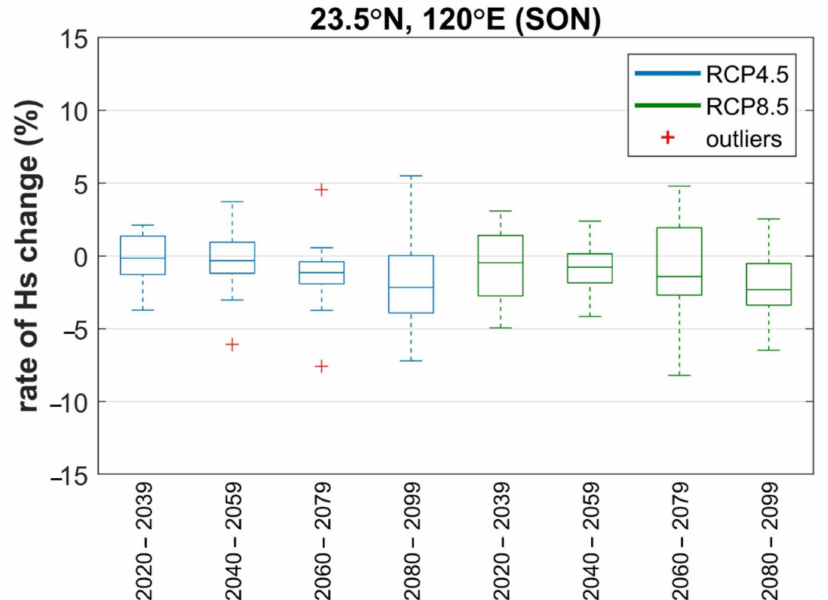
Figure 19. Box plot of rate of change in the seasonal mean of significant wave heights for each GCM, with respect to the reference period from 1980 to 2004 in the region of Taiwan, in autumn at 23.5 ◦ N,